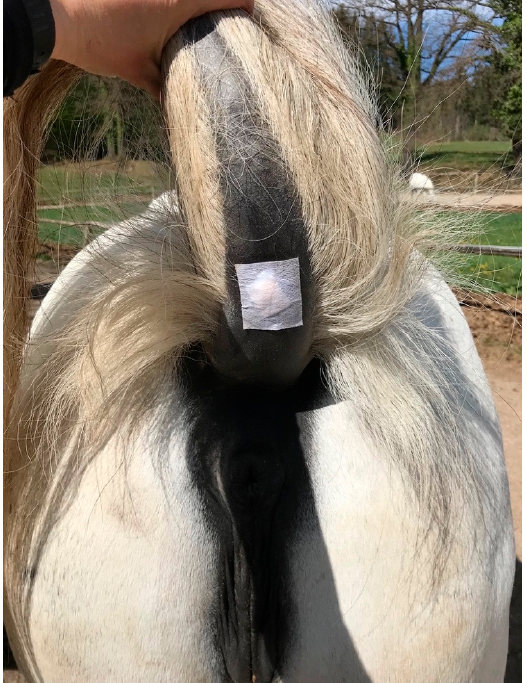
Figure 1. Covering the treatment site. Each tumor was treated topically with a placebo, a 1% BA cream or a 1% NVX-207 cream and subsequently covered in order to prevent the cream from being rubbed off. Any cream residues from previous treatments were removed with a swab once a day. If necessary, the skin was degreased with swabs soaked in 70% ethanol to ensure the fixation of the